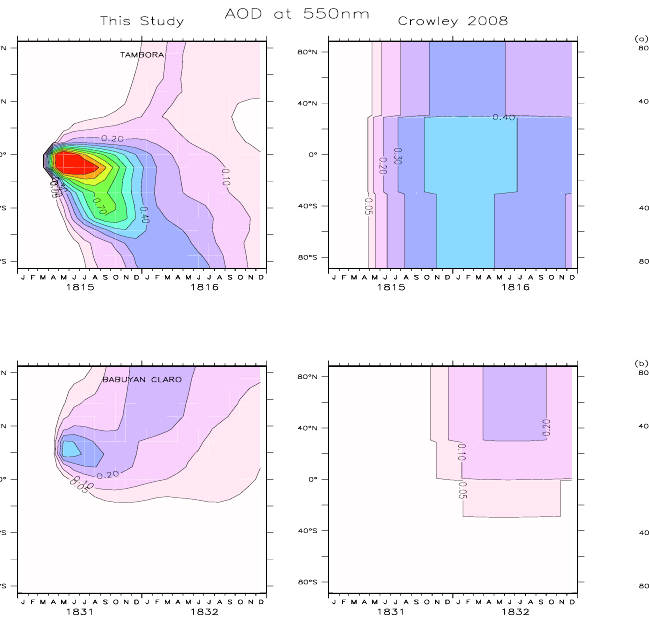
Fig. 7. Latitudinal distribution of the optical depth in VIS (550nm) for the Cosiguina (1835) and Krakatau (1883) eruptions for this study (left column) and Crowley et al. (2008) (right column).